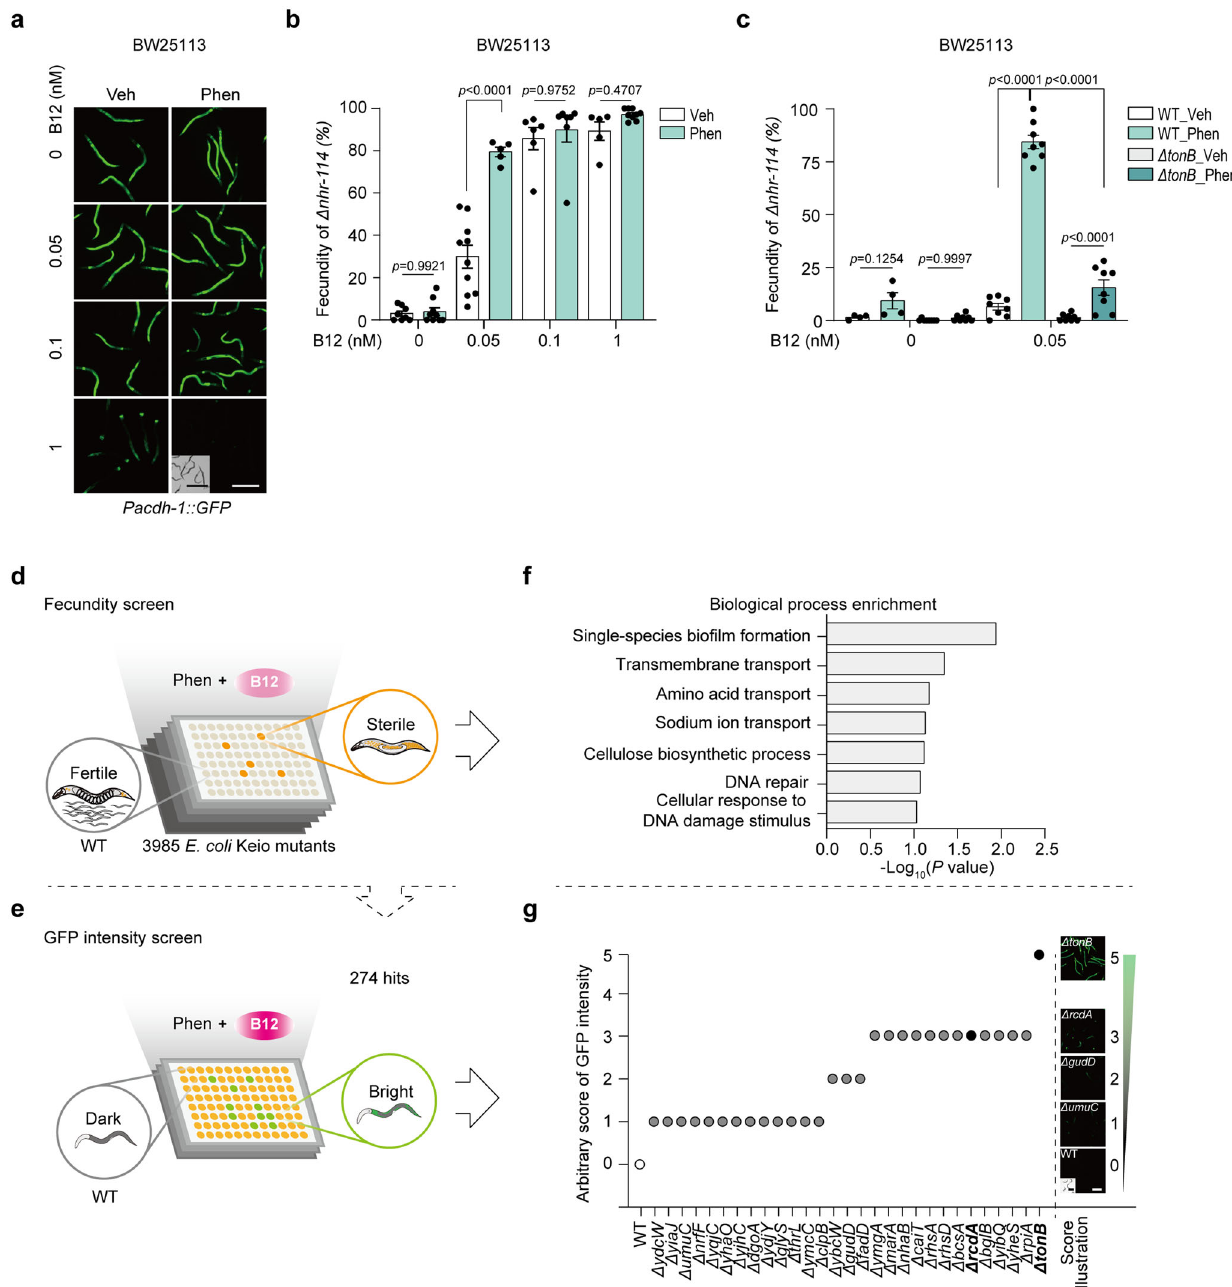
Fig. 3 Bacterial genetic screens to identify the effectors of phenformin with worm B12 sensors. a Representative images of Pacdh-1::GFP worms fed BW25113 pretreated with various doses of B12 and/or 4 mM phenformin. N = 3 independent experiments containing at least 30 worms per group. b The fecundity of Δ nhr-114 worms fed BW25113 pretreated with various doses of B12 and/or 2 mM phenformin. N = 5 independent experiments containing 1 – 2 replicates per experiment. c The fecundity of Δ nhr-114 worms fed WT and Δ tonB bacteria pretreated with 0.05 nM B12 and/or 2 mM phenformin. N = 4 independent experiments containing 1 – 2 replicates each time. The statistical signi fi cance values were determined by two-way ANOVA for ( b , c ). Error bars denoted the S.E.M. d , e Schemes of genetic screens for genes responsible for phenformin-mediated bacterial B12 accumulation. Fecundity screen ( d ). The cartoons of sterile and fertile Δ nhr-114 worms were adapted from our previous work 25 . The whole library was screened using Δ nhr-114 worms treated with 2 mM phenformin and 0.05 nM B12. N = 4 independent experiments containing at least 30 worms per well and each round. GFP intensity screen ( e ). A total of 274 hits from the fecundity screen were screened using Pacdh-1::GFP worms treated with 4 mM phenformin and 1 nM B12. N = 3 independent experiments containing at least 30 worms per well and each round. f Biological process enrichment analysis of 274 hits from the fecundity screen. g The fl uorescence scores of Pacdh-1::GFP worms on WT and 28 hits from the GFP intensity screen. Scale bar: 250 μ m ( fl uorescence images) and 500 μ m (bright fi eld images) for ( a ) and ( g